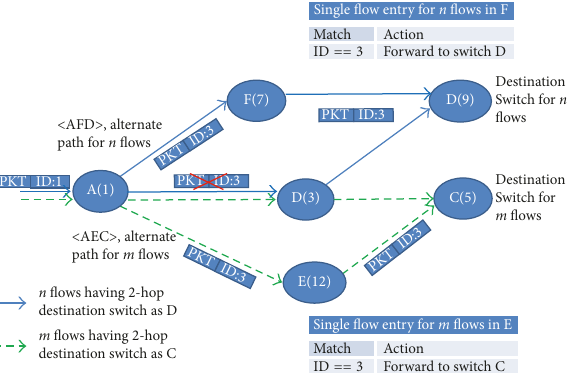
Figure 4: Link failure recovery model for SDN